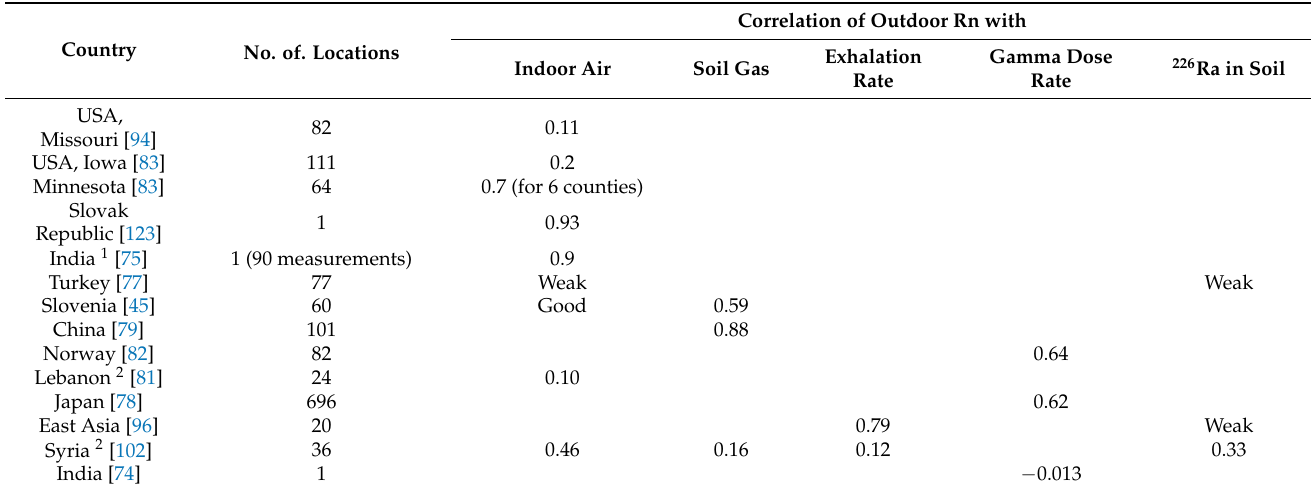
Table 3. Correlation of outdoor radon concentrations with other radon